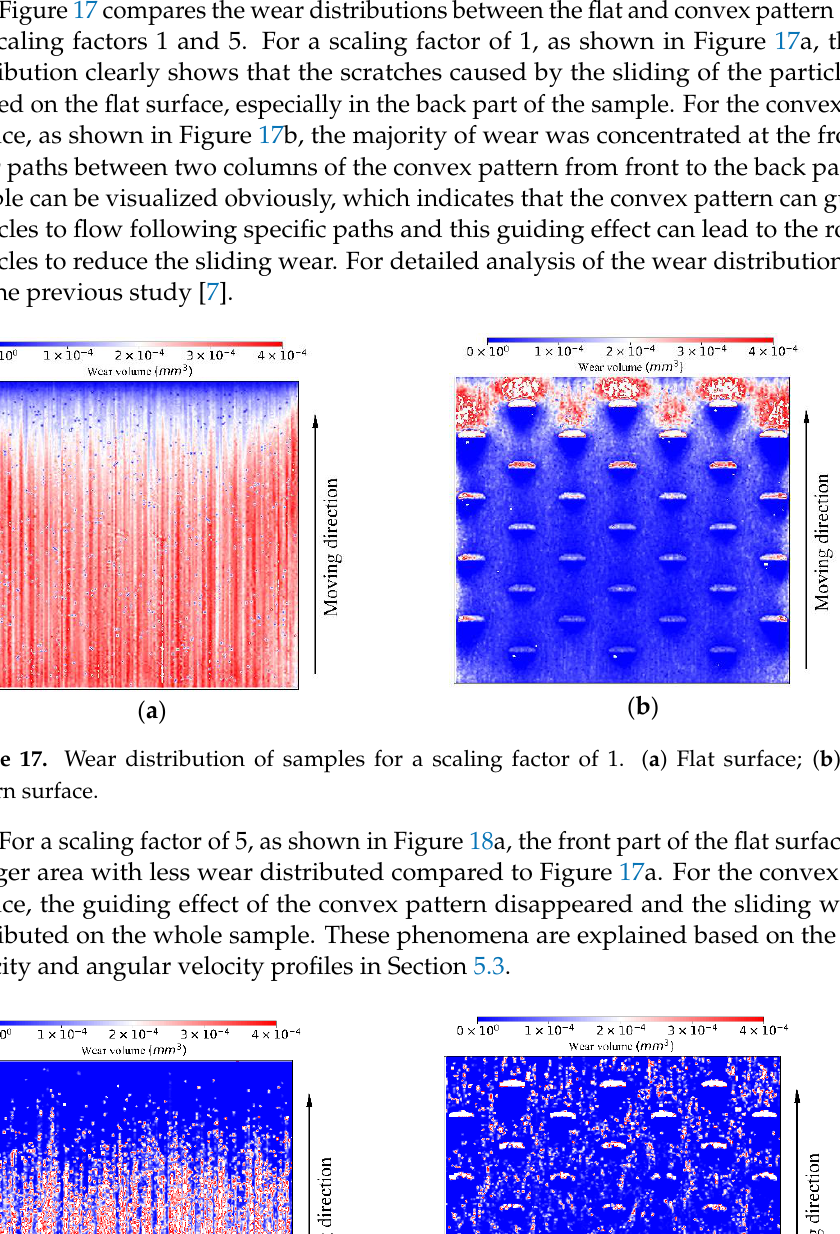
Figure 18. Wear distribution of samples for a scaling factor of 5. ( a ) Flat surface; ( b ) Convex pattern